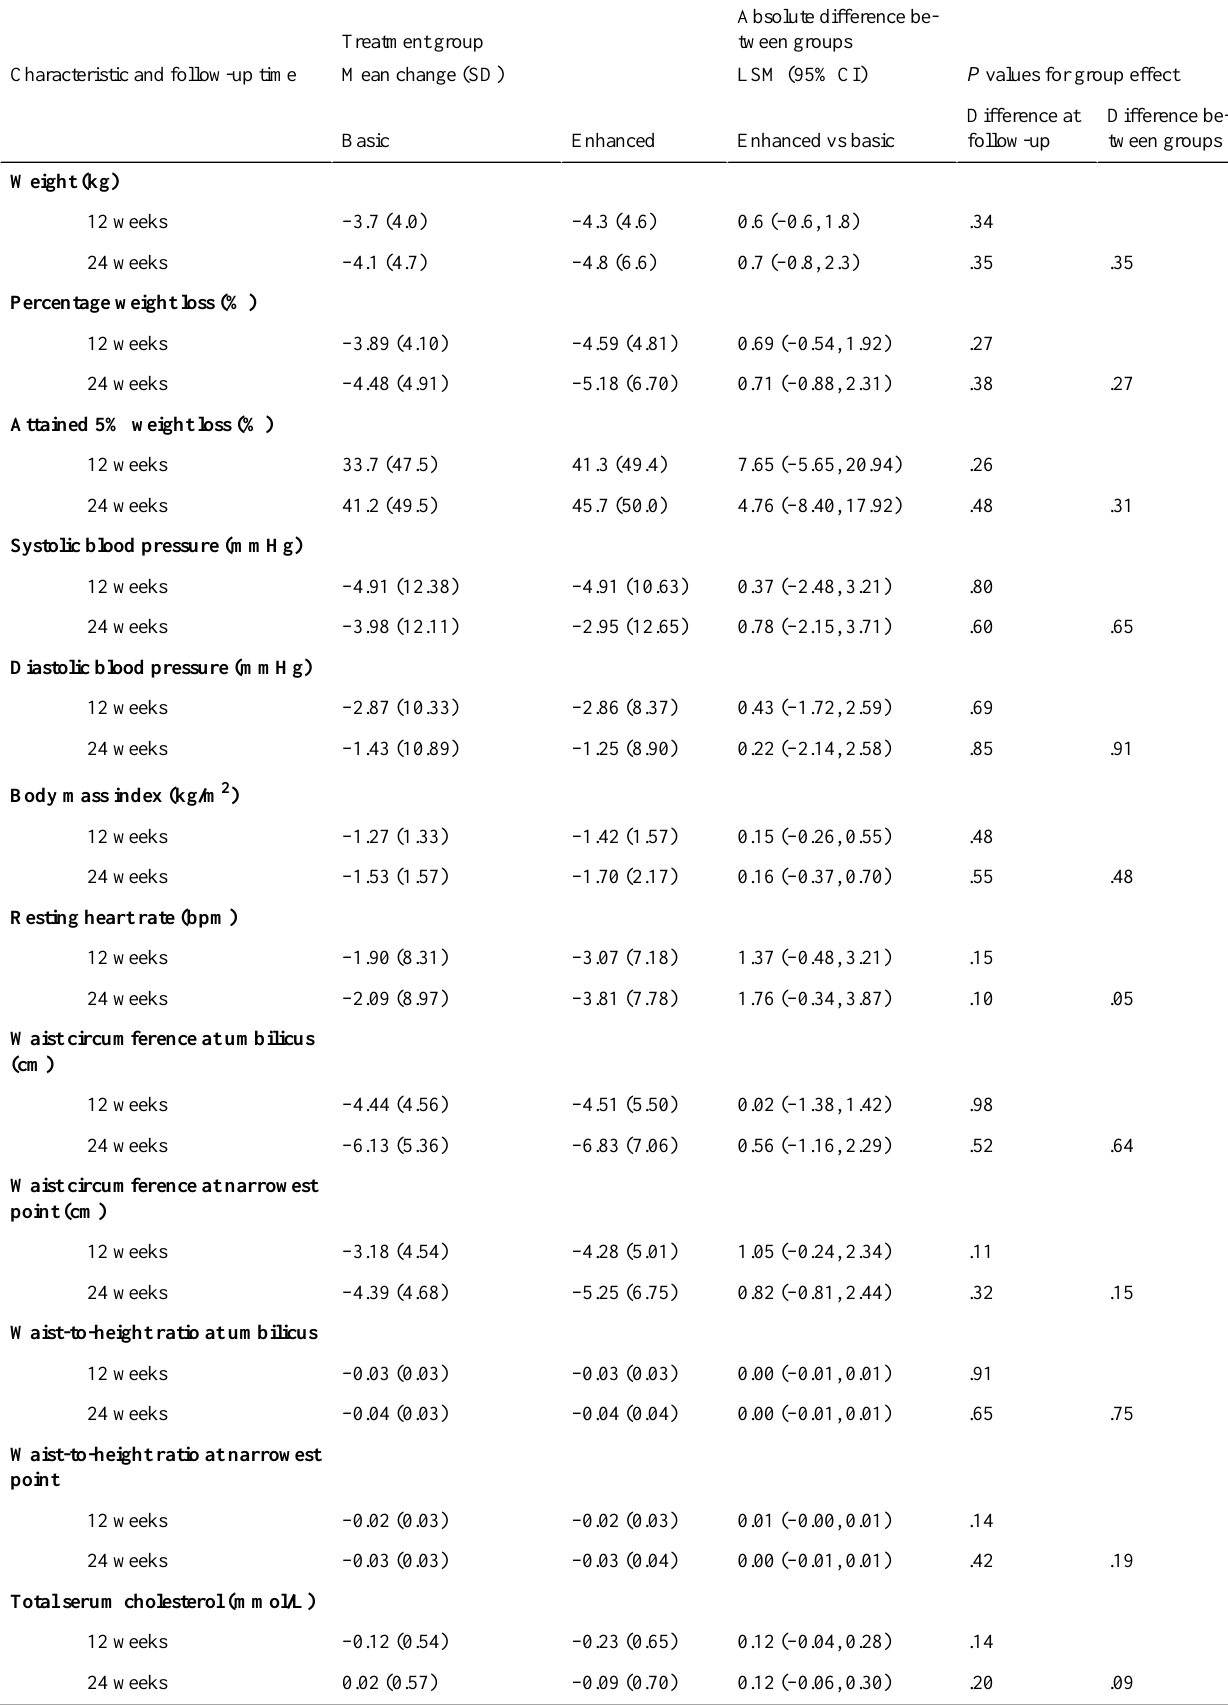
Table 5. Mean change in a range of variables from baseline to 12 weeks and baseline to 24 weeks within each treatment group and the least squares mean (LSM) difference in change between treatment groups (completers